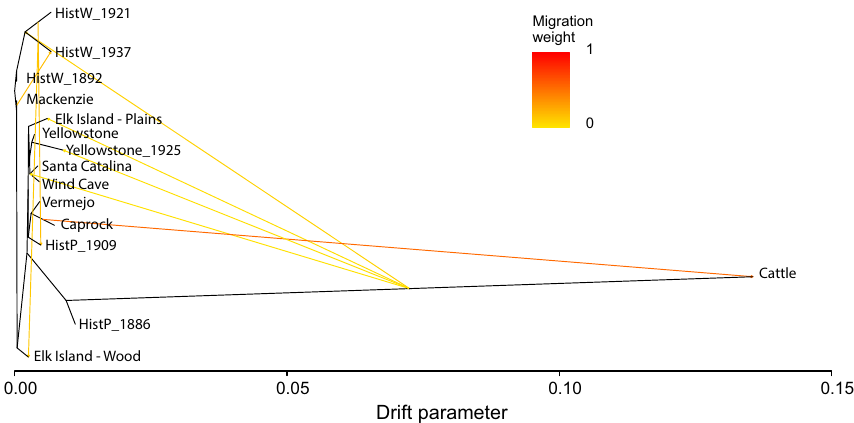
Figure 3. TreeMix estimation of phylogenetic network and relationships among bison populations and domestic cattle with eight migration events. All modern bison were assigned to their respective populations while historic samples were included as individuals. A representative of each of the four cattle breeds (Angus, Charolais, Hereford, and Holstein) were assigned to the cattle population. Of the migration edges five of the eight are between the cattle lineage and bison populations. The migration with the highest weight is shown between cattle and Caprock while migrations of smaller weights can be seen between Cattle and historical wood bison, Elk Island-Plains, Yellowstone and a group consisting of Wind Cave and Santa Catalina. Three additional migration events can be seen between historical wood bison and modern wood bison populations as well as between historical plains and wood bison. These migration events shown agree with the historic documentation of introgression events and movements of bison.